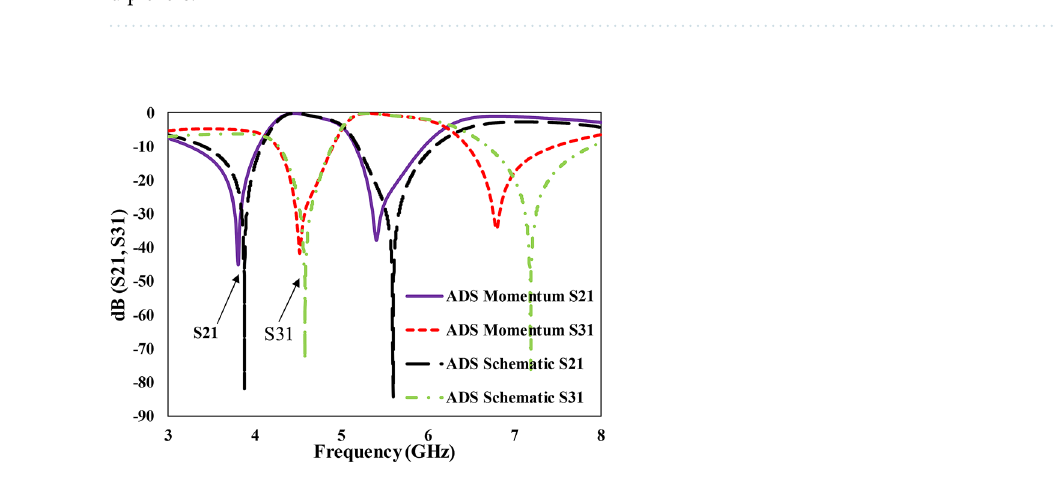
Table 1. Comparison of the proposed diplexer based on the EIT-like effect with reported state-of-the-art diplexers.